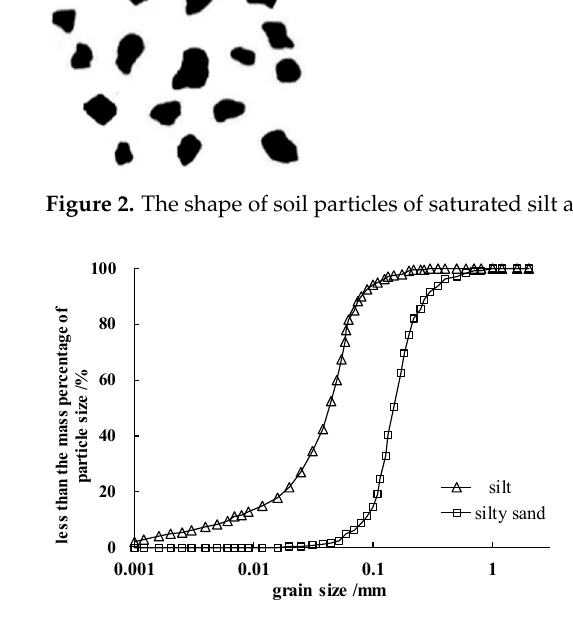
Figure 3. Soil particle grading curves (a. silt; b. silty sand).